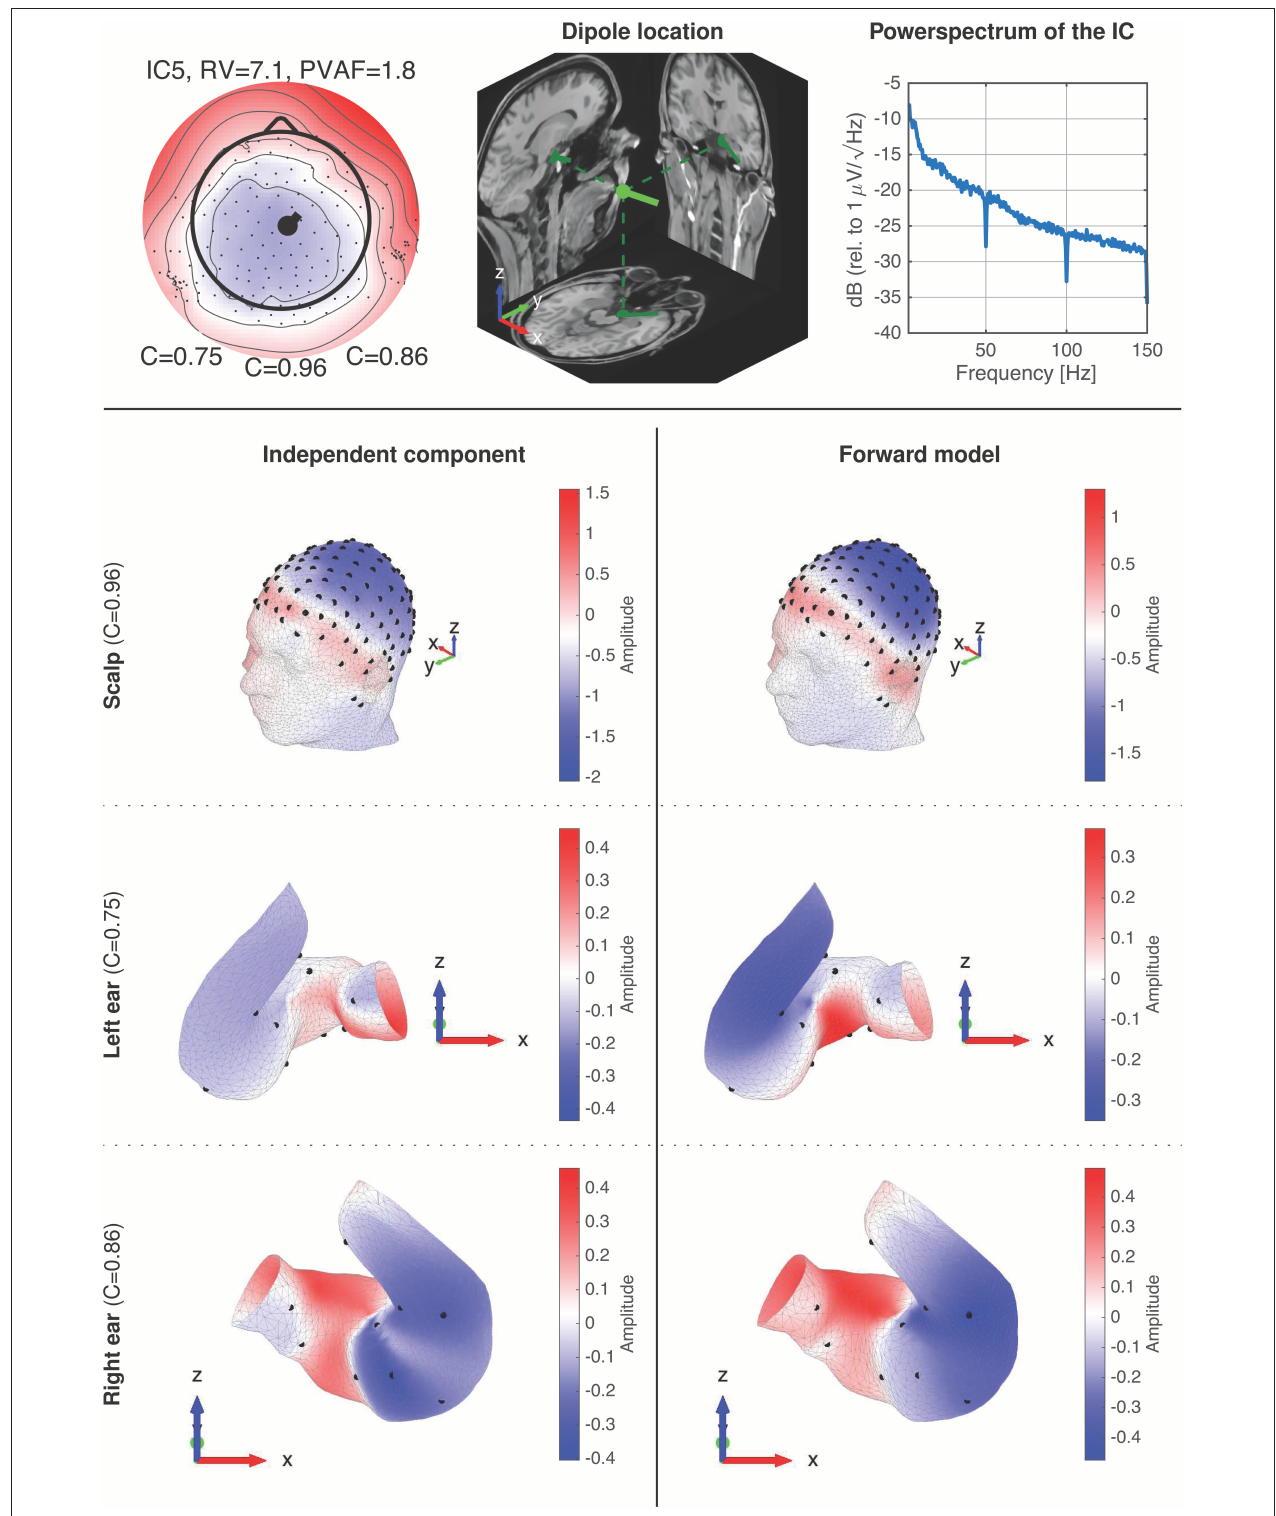
FIGURE 10 | Details of IC5A with corresponding forward model data. The first row shows the component map, dipole location, and power spectrum for the IC. The dipole location shows the dipole location and orientation determined by single dipole fitting of the IC. The 2-4th rows show topographic 3D maps for the scalp, the left ear, and the right ear, respectively. The left column (row 2–4) is the topographic maps (i.e., component maps) for the IC, and the right column is the corresponding topographic maps modeled with the ear-EEG forward model for the subject.